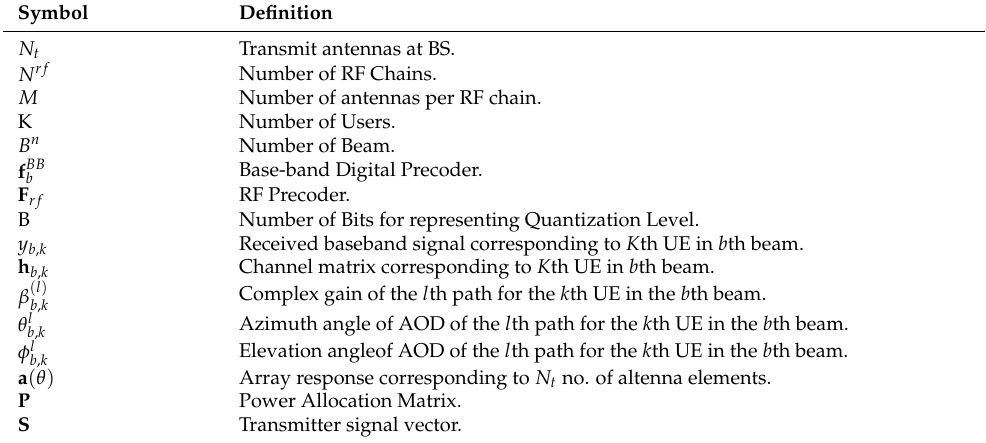
Figure 1. The system model for HP-aided mmWave mMIMO-NOMA with sub-connected architecture. Table 2. List of symbols and corresponding